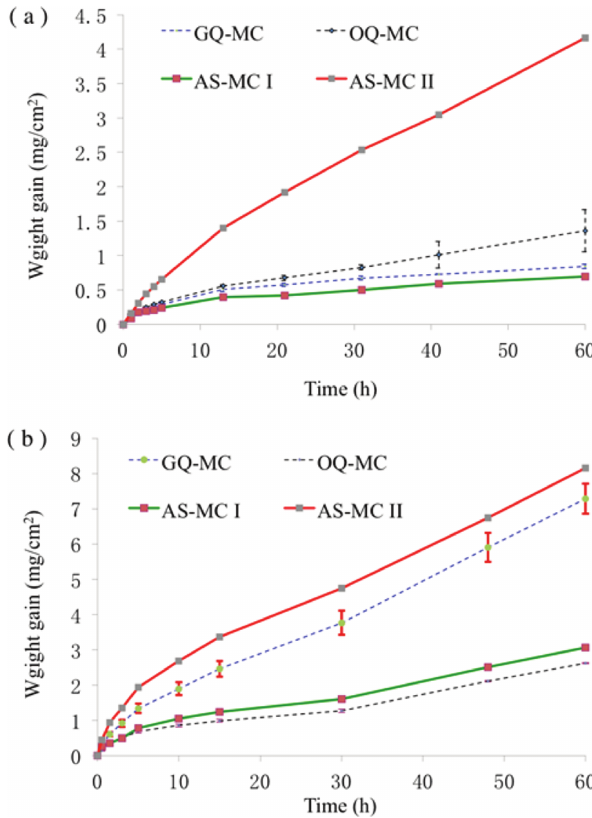
Figure 14: Static oxidation kinetic curves of multilayered coatings with different temperature (a) 600°C, (b)